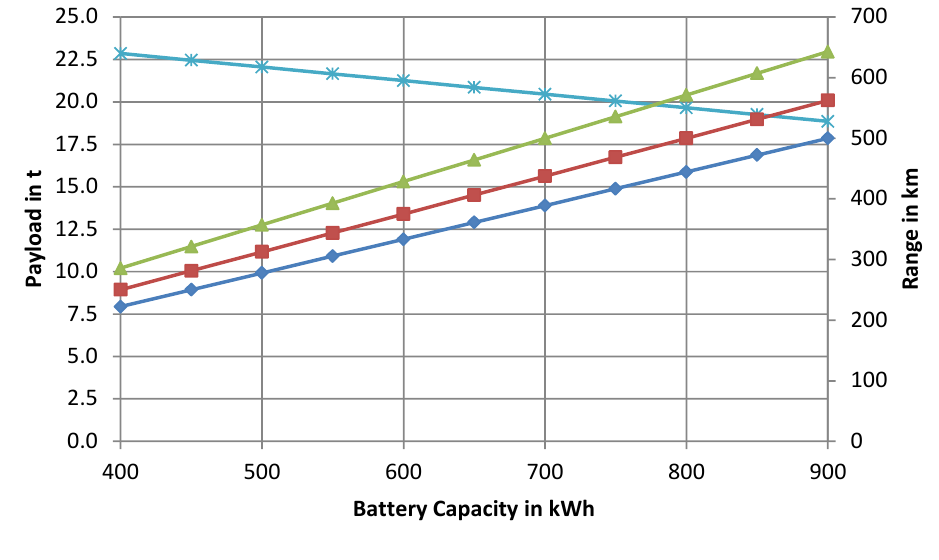
Figure 13. Weight breakdown of main truck components for the diesel trucks and battery electric trucks with different traction batteries.